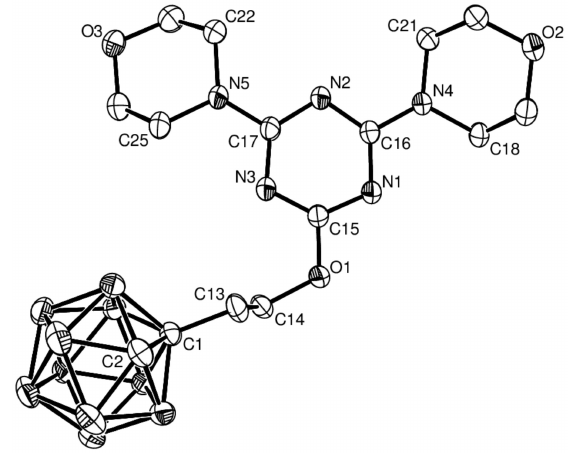
Figure 2. Molecular structure of 6 with thermal ellipsoids drawn at the 30% level. Hydrogen atoms are omitted for clarity. Table 1. Crystal data and structure refinement of 5 and 6